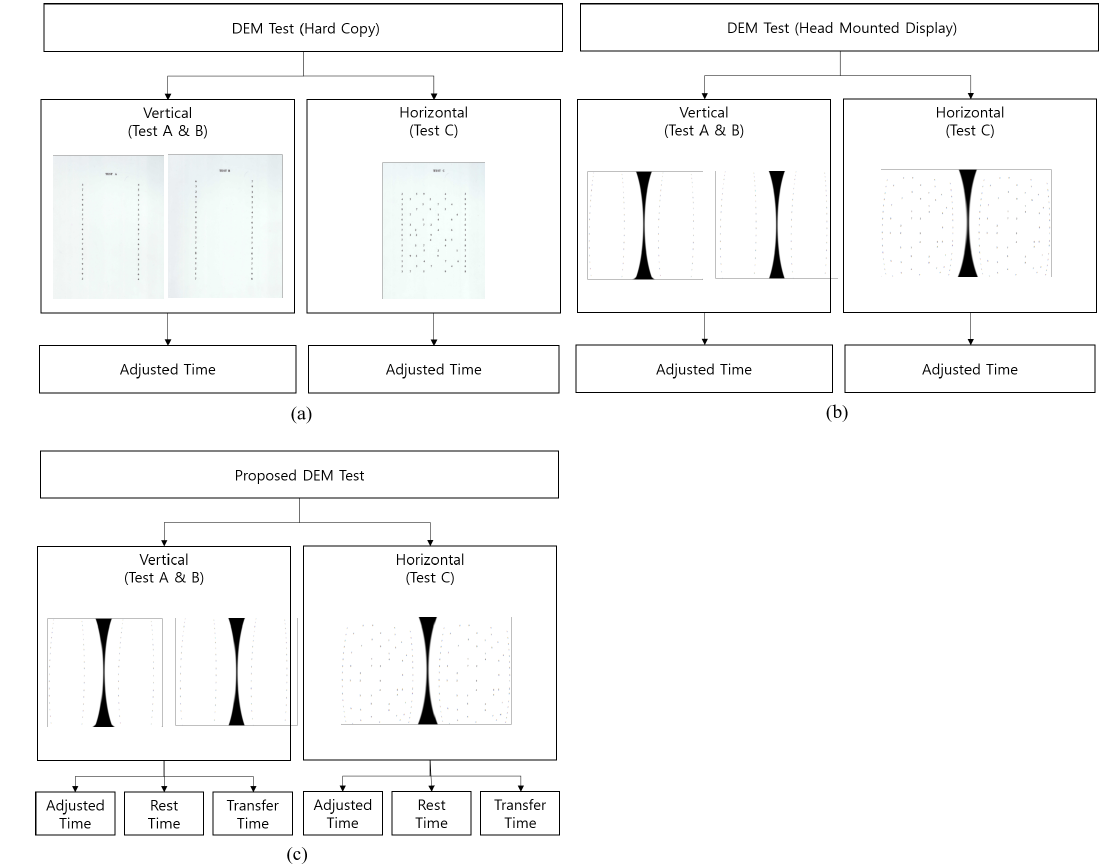
Figure 2. A comparison of the proposed and traditional methods for measuring saccadic eye movement: ( a ) A hard copy of the Developmental Eye Movement (DEM) test charts; ( b ) The DEM test charts incorporated into the VR HMD; ( c ) The proposed method of measurements with the DEM test charts incorporated into the VR